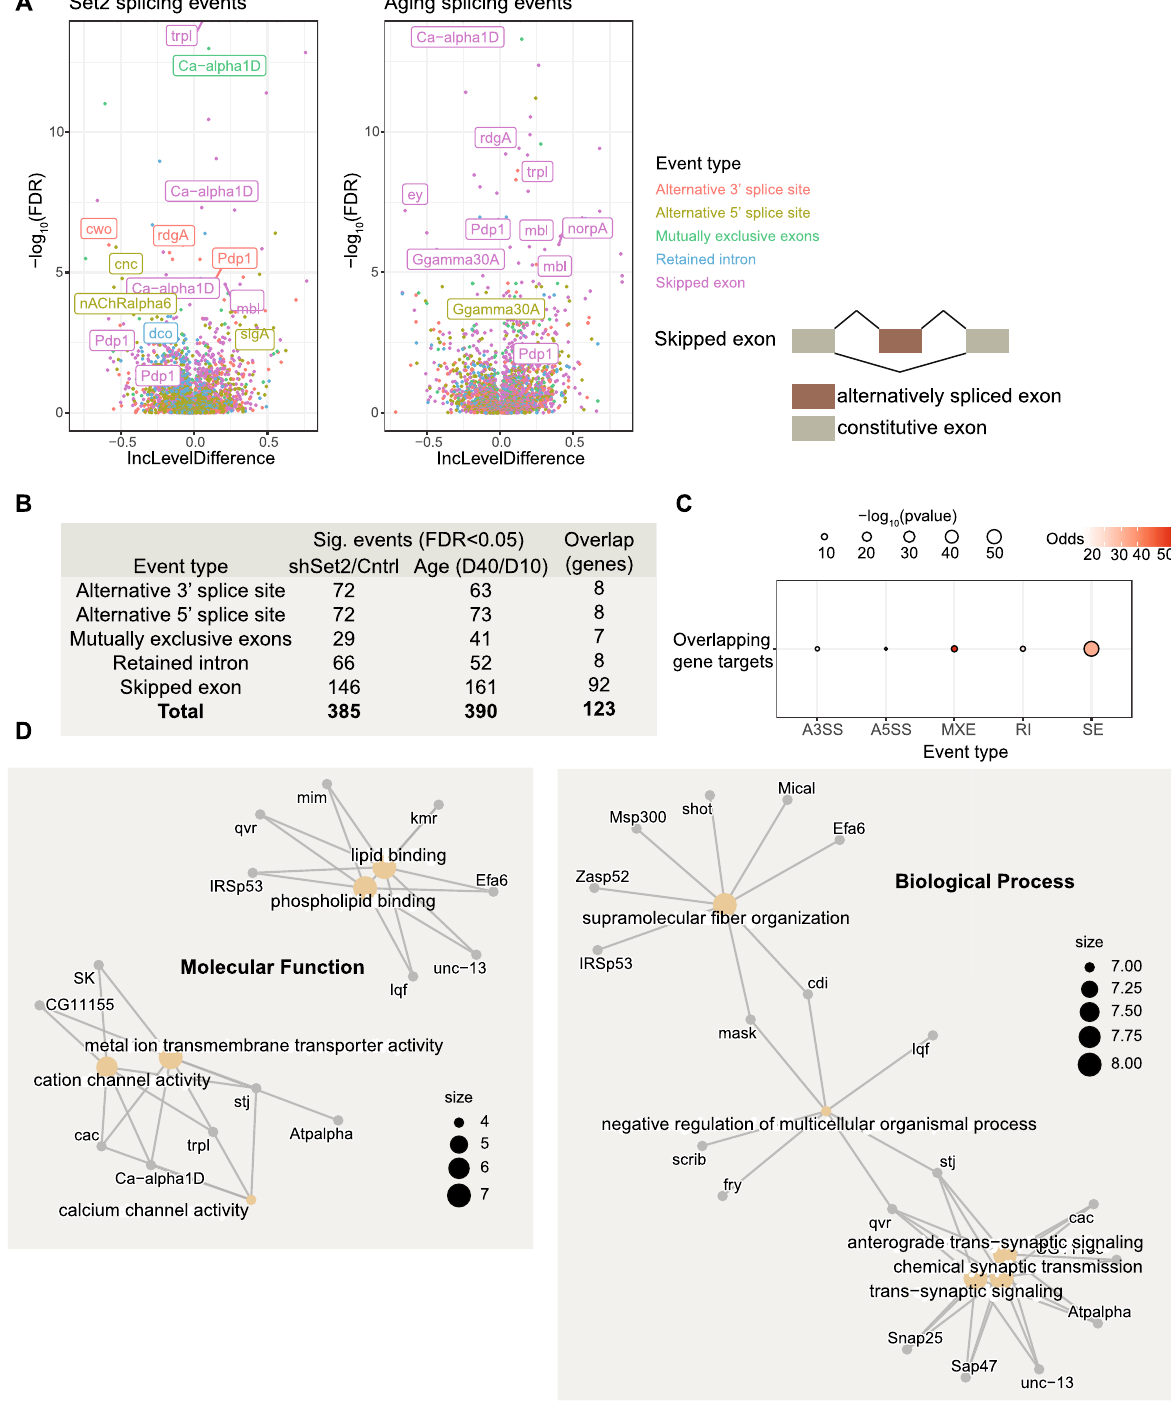
Figure 4. Set2 knockdown leads to differential splicing outcomes that resemble those observed in aging photoreceptors. ( A ) Volcano plot representing the differential splicing events identified in shSet2 versus shCntrl at day 10 (left) or aging (day 10 versus day 40) photoreceptors using rMATS. Splicing events are colored by event type, and genes important for photoreceptor function are highlighted. A schematic illustrating skipped exon events is shown to the right. ( B ) Table showing the total number of statistically significant events in each category identified using rMATS in aging (D40 vs D10) or upon loss of Set2 (shSet vs shCtrl). Overlapping gene targets for each event are shown in the right column. ( C ) Dot plot representing the overlap analysis of splicing events between aging and Set2-deficient photoreceptors. Statistical significance is obtained performing a hypergeometric test. A higher Odds ratio represents similarity between datasets, with values below 1 indicating no association. ( D ) Gene Concept Network (cnet) plots illustrating individual genes driving the statistically significant enrichment of GeneOntology (GO) Biological Process and Molecular Function terms identified for the shared splicing events for Set2 and aging